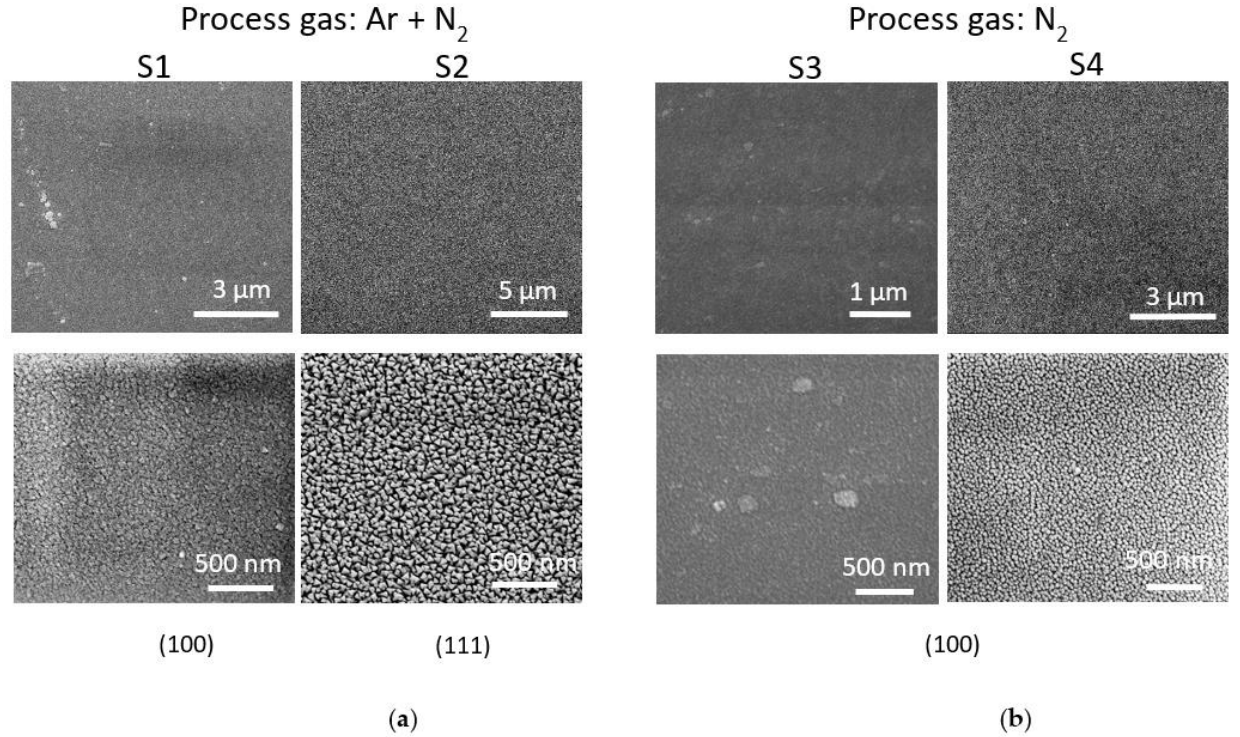
Figure 4. FESEM images of the surface of the Cu 3 N samples deposited in ( a ) N 2 + Ar and ( b ) pure N 2 environments. Information concerning the preferred orientation extracted from the XRD analysis is also included.